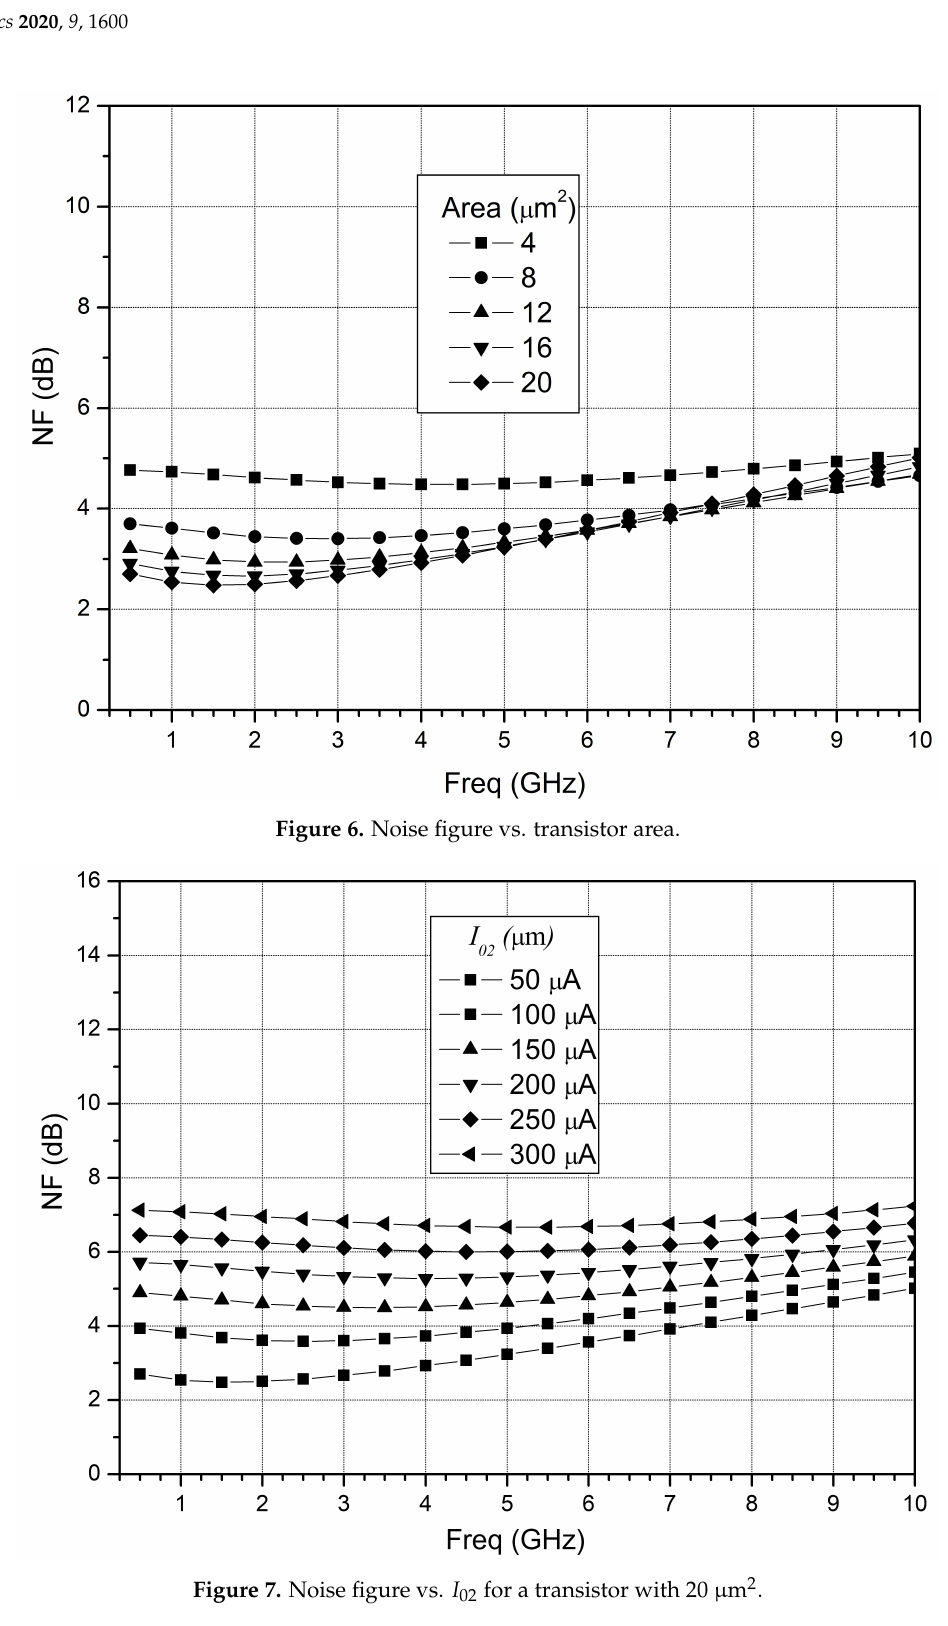
Figure 7. Noise figure vs. I 02 for a transistor with 20 µ m 2